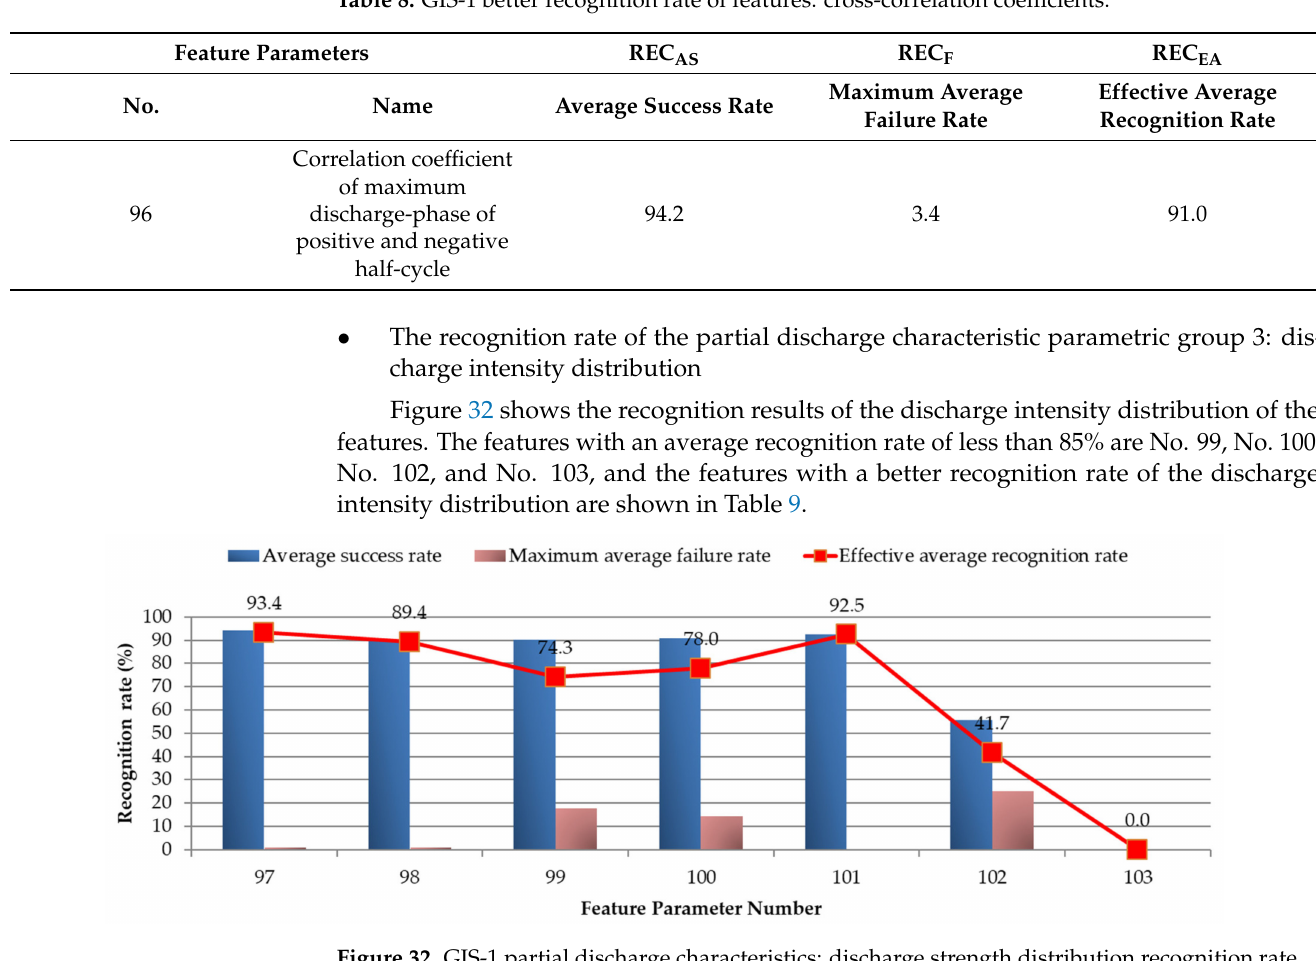
Figure 31. GIS-1 partial discharge parameter: cross-correlation coefficient recognition rate. Table 8. GIS-1 better recognition rate of features: cross-correlation coefficients.